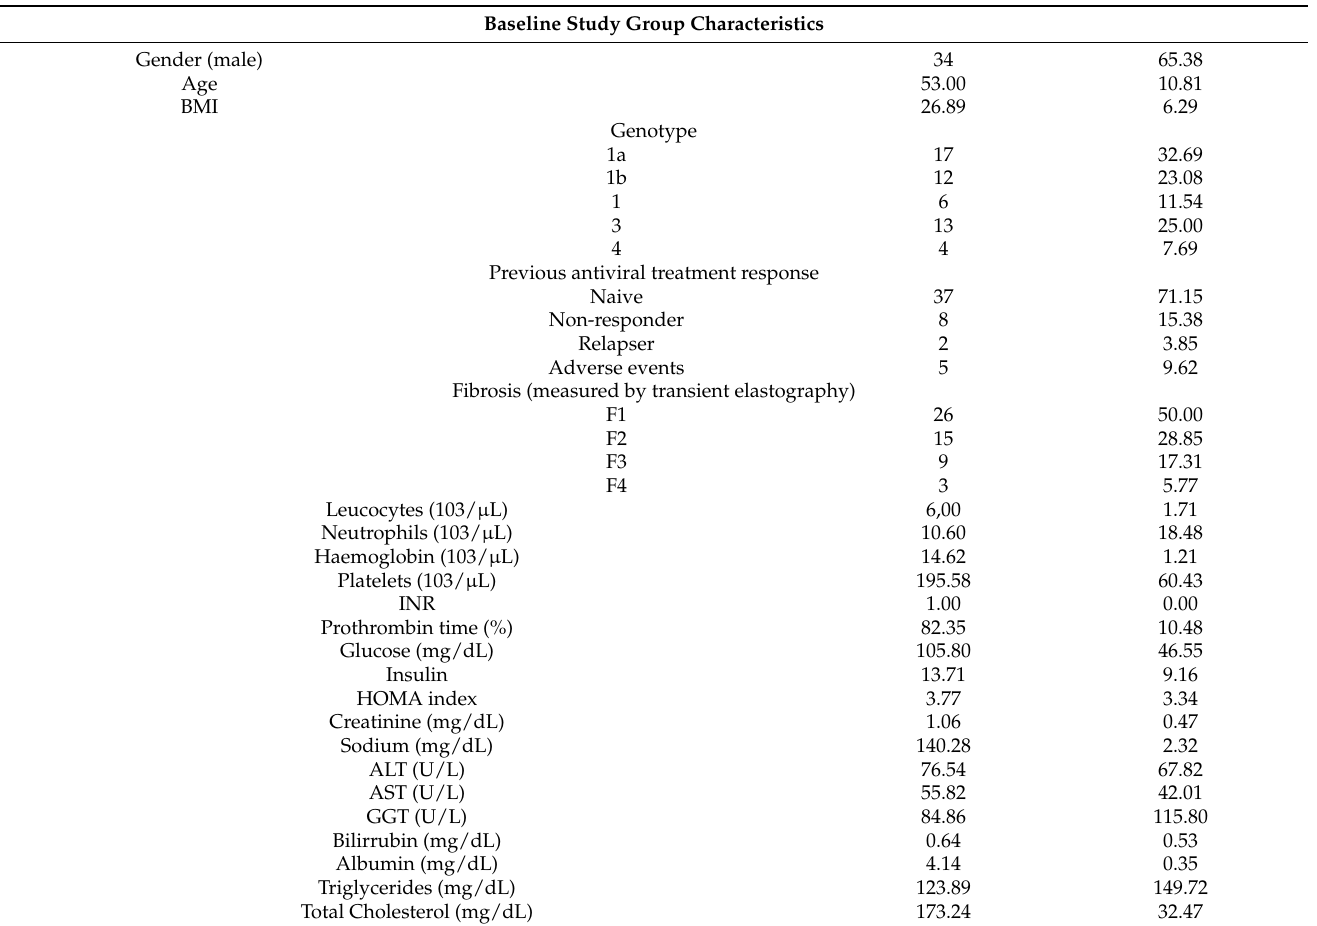
Table 2. Basal clinical and analytical characteristics of the study population. Baseline Study Group